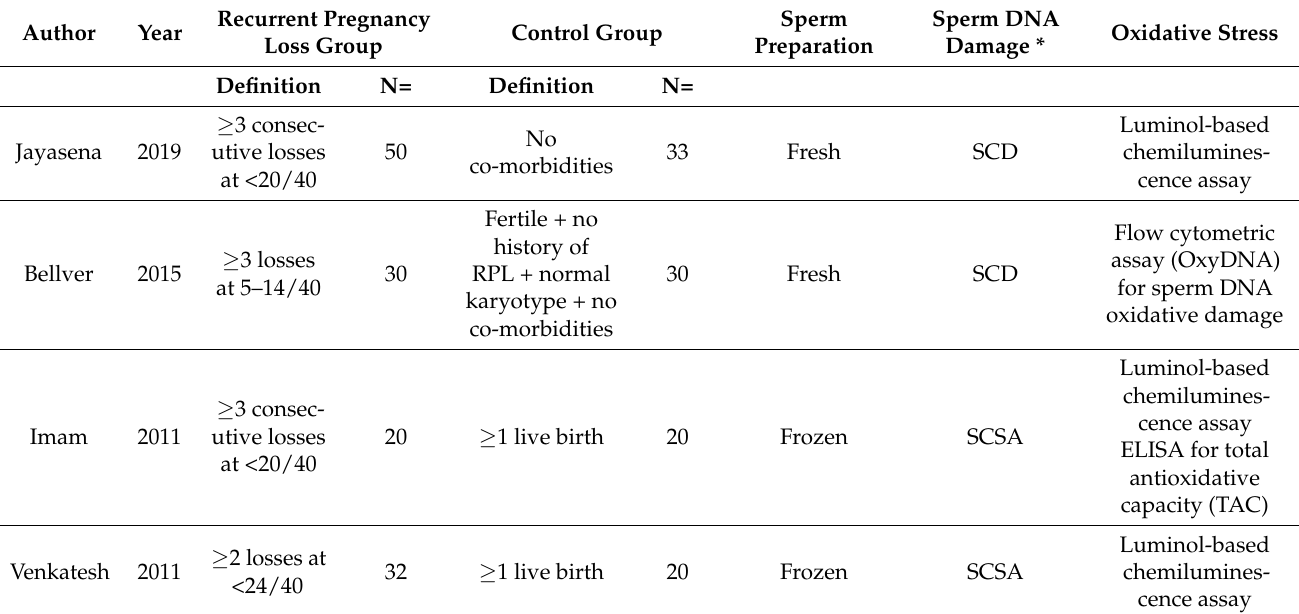
Table 1. Qualitative analysis of studies on recurrent pregnancy loss, sperm DNA damage and reactive oxygen